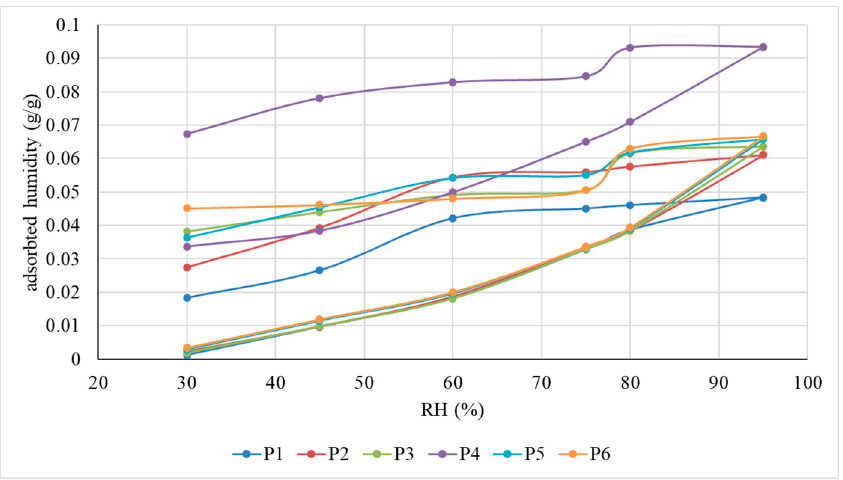
Figure 3. Atmospheric moisture sorption–desorption curves.